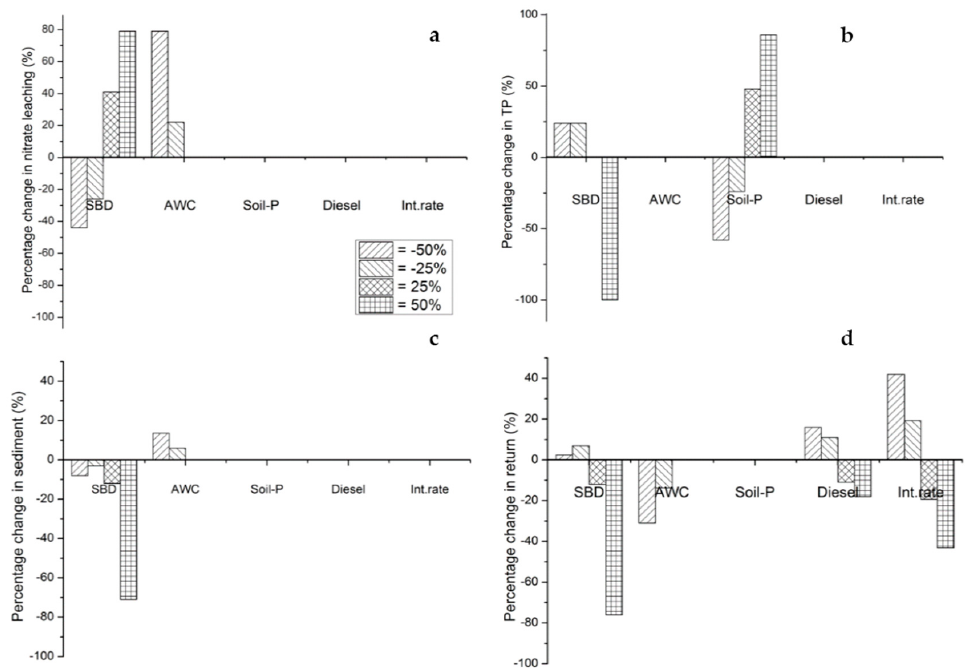
Figure 5. Sensitivity analysis at VLJF showing impact of changing input parameters (SBD = soil bulk density, AWC = available water content, Soil-P = soil phosphorus concentration) on ( a ) nitrogen leaching; ( b ) TP runoff; ( c ) sediment loss and ( d ) return to management.